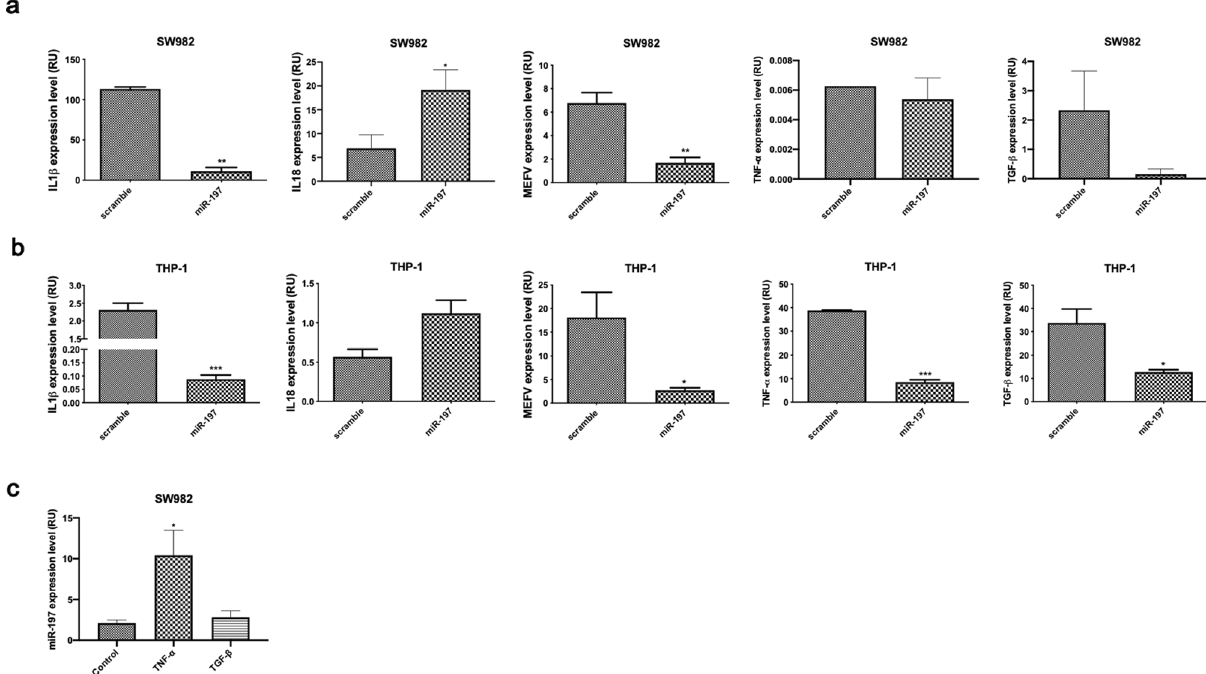
Figure 1. miR-197-3p suppresses the expression of inflammatory cytokines and genes. (a) qPCR measurement of IL-1β , IL-18 , MEFV , TNF-α, and TGF-β gene expression levels in miR-197-3p or control sequence- transfected (scramble/mimic control) SW982 cell line. Data represent the mean ± standard deviation from three independent experiments. * P < 0.05; ** P < 0.01, Student’s t-test (two-tailed). ( b) qPCR measurement of IL-1β, IL-18, MEFV, TNF-α, and TGF-β gene expression levels in miR-197-3p or control sequence- transfected (scramble/mimic control) THP-1 cell line. Data represent the mean ± standard deviation from three independent experiments. * P < 0.05; ** P < 0.01, Student’s t-test (two-tailed). ( c) miR-197-3p expression level in SW982 cell line after TNF-α and TGF-β applications. Data represent the mean ± standard deviation from three independent experiments. * P < 0.05, Student’s t-test